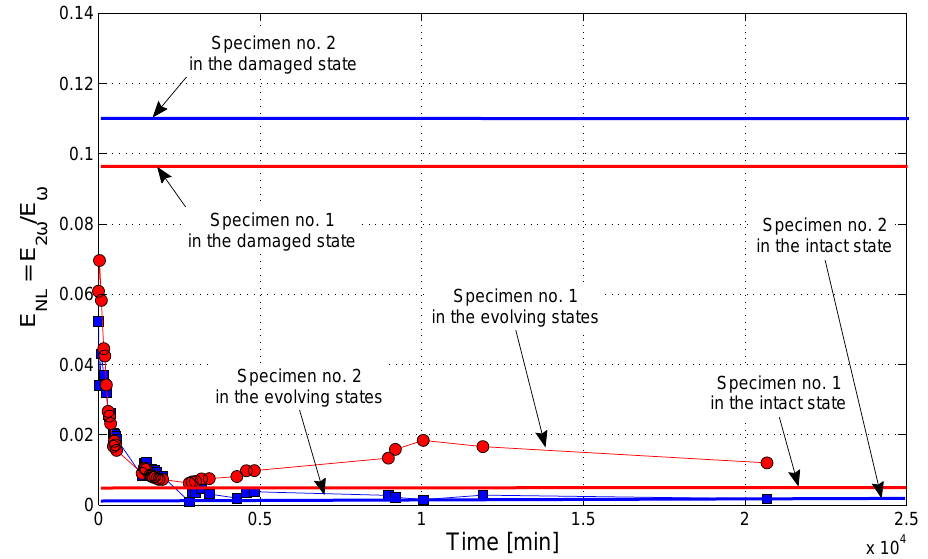
Figure 6. Nonlinear effect of second harmonic generation under continuous sine excitation as a function of healing time for Specimen No. 1 and Specimen No.